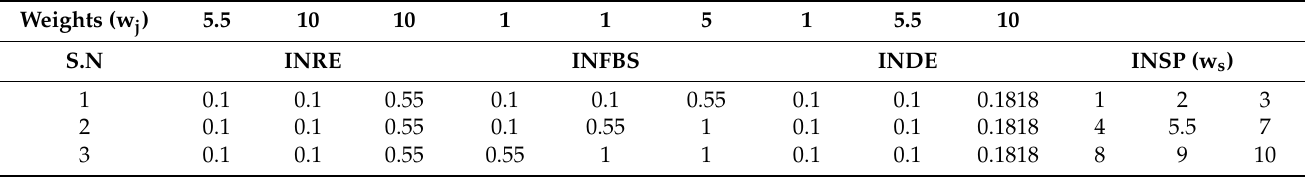
Table 7. Normalized Fuzzy decision